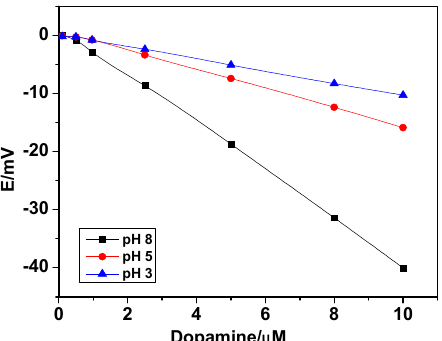
Figure 7. Potentiometric response of the proposed sensor at different pH values in 10-mM PBS buffer + 1-mM NaCl.3.3. Sensor Selectivity.